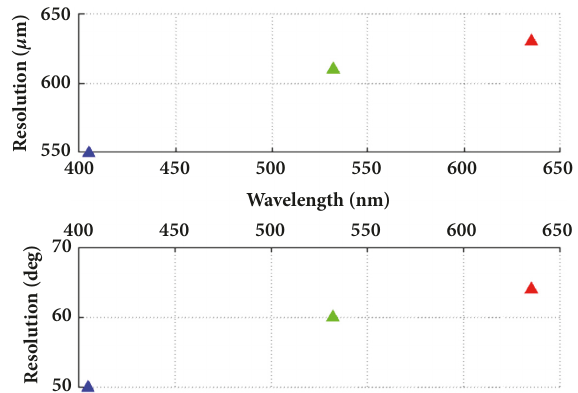
Figure8:Resultsfromspectralresponsesimulations.Increasingthewavelengthhasanegativeeffectontheresolutionoftheproposedsystem. Resolution is measurement in terms of the FWHM of the imaged fluorescence